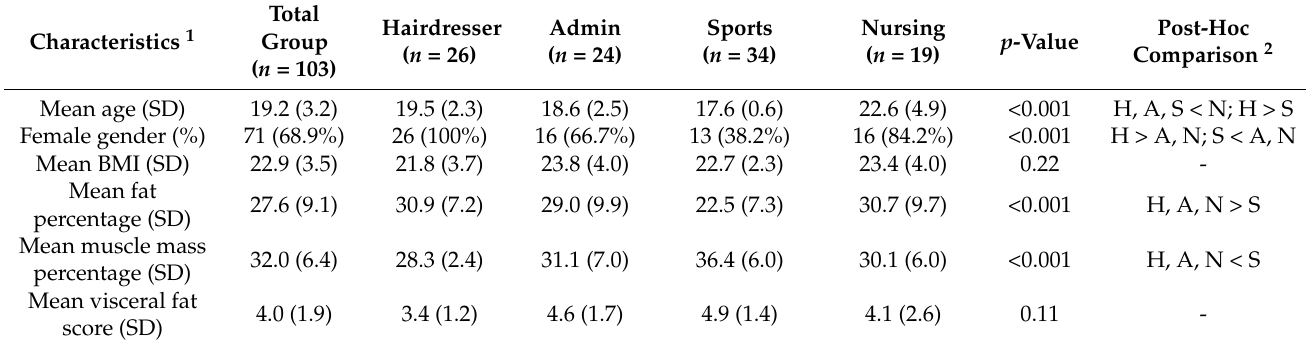
Table 1. Descriptive statistics and differences between educational tracks for demographics and body composition variables.